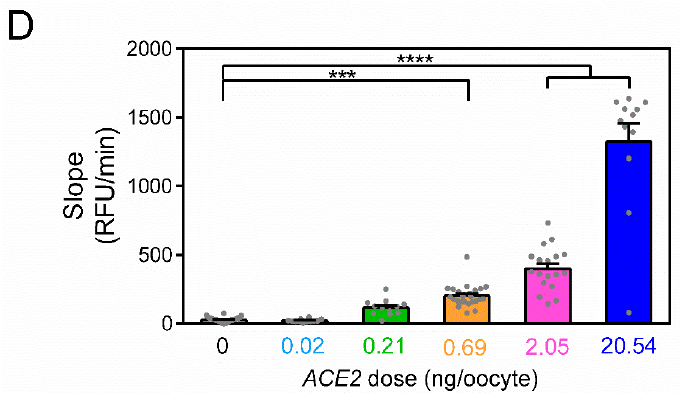
Figure 2. ACE2 activity in Xenopus laevis oocytes is dose-dependent on the amount of injected cRNA encoding the enzyme . ( A ) Fluorometric ACE2 activity (measured as slope between 15 and 30 min) in four batches of uninjected oocytes. Each dot represents a biological replicate (N = 6, 12, 12 and 12 oocytes per batch, respectively for batches 1–4). ( B ) Fluorometric ACE2 activity for all uninjected oocytes in ( A ) (slope = 27.4 ± 2.7 RFU/min, N = 42) and mock-injected oocytes (slope = 23.4 ± 4.5 RFU/min, N = 12). ACE2 activity does not differ between uninjected and mock-injected oocytes ( p = 0.48, unpaired t -test). ( C ) Representative traces of ACE2 activity in uninjected, mock-injected, and ACE2 cRNA-injected oocytes (0.02–20.54 ng of cRNA). Inset (grey) shows the initial 10 min. ( D ) ACE2 activity in uninjected and injected oocytes (0.02–20.54 ng ACE2 cRNA). The number of oocytes was 42 for uninjected, 12 for 0.02, 0.21, and 20.54 ng, 25 for 0.69 ng, and 18 for 2.05 ng ACE2 cRNA. ***, p < 0.001 and ****, p < 0.0001 for ANOVA with Dunnett’s multiple comparisons test. Horizontal bars indicate average values and error bars represent standard errors of the